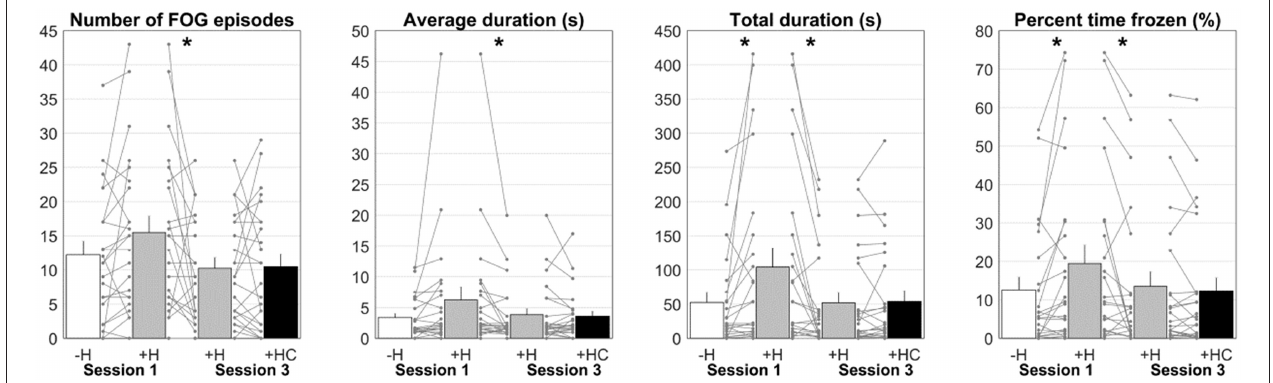
FIGURE 5 | Number of FOG episodes, average duration, total duration, and percent time frozen for Session 1 without HoloLens (–H; white bar) and with HoloLens ( + H; gray bar) and Session 3 with HoloLens ( + H; gray bar) and with Holocue ( + HC; black bar). Asterisks indicate significant comparisons. Each line represents a